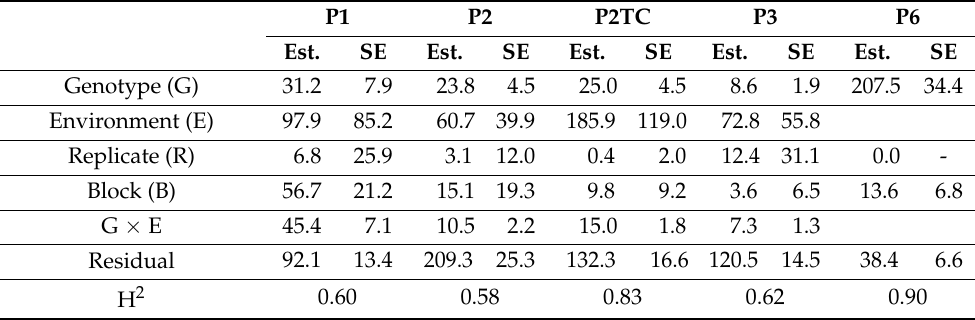
Table 8. Variance components (Est.) with standard errors (SE) and heritability (H 2 ) for leaf rust severity.